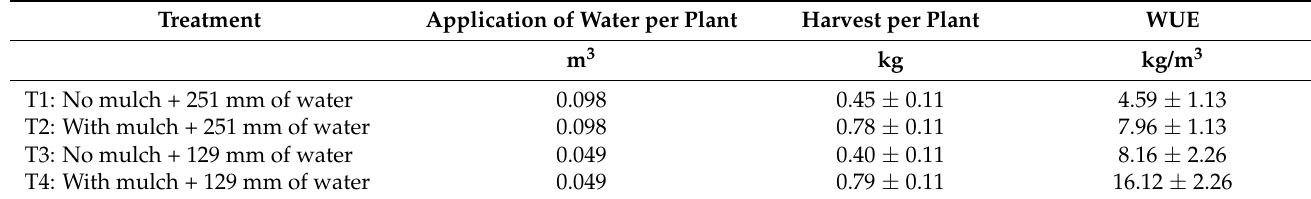
Table 8. Water use efficiency in different treatments based on pepper crop yield. Treatment Application of Water per Plant Harvest per